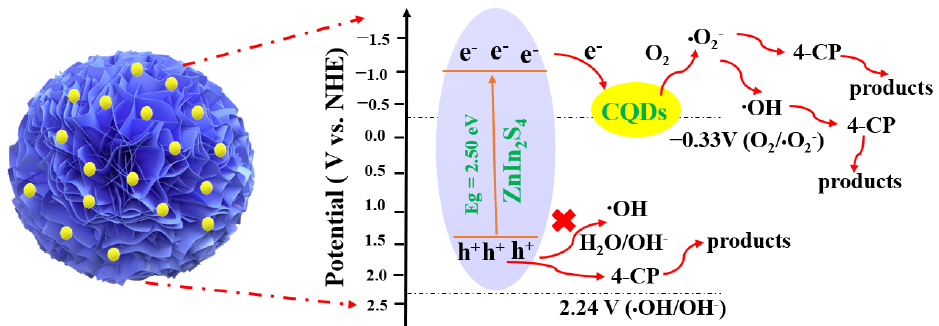
Figure 5. Degradation mechanism of CQDs/ZnIn 2 S 4 -2 toward 4-CP under Xe lamp irradiation.